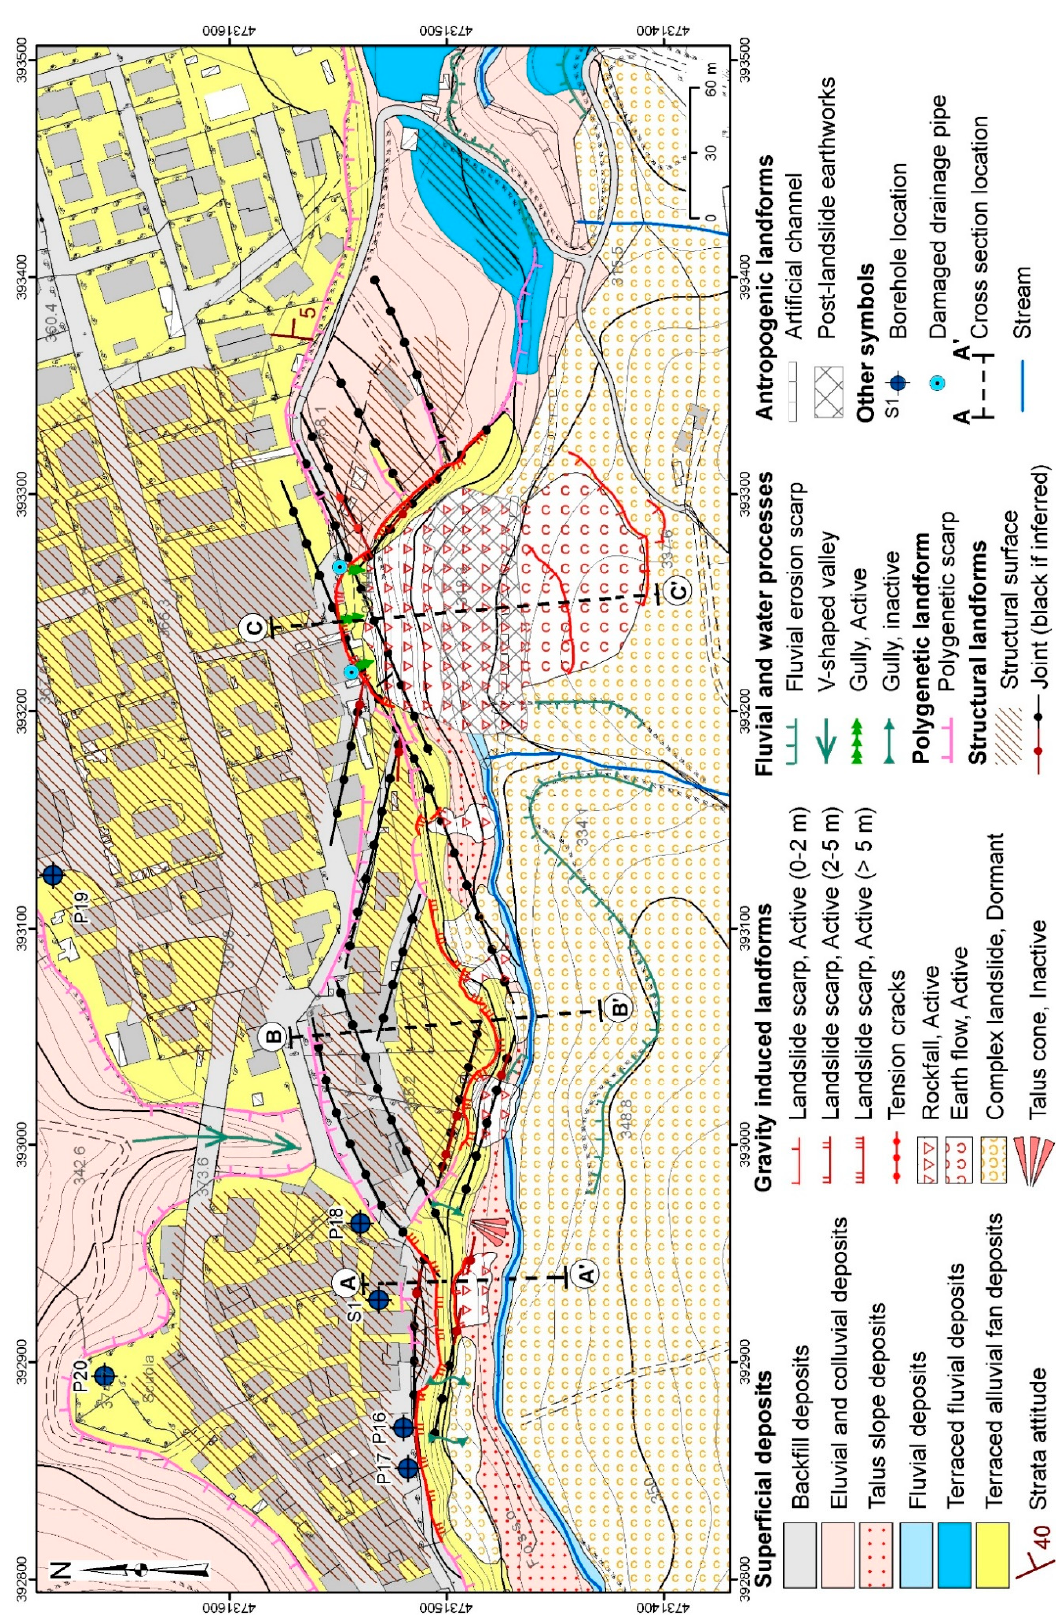
Figure 14. Geological and geomorphological map of the Castelnuovo area.